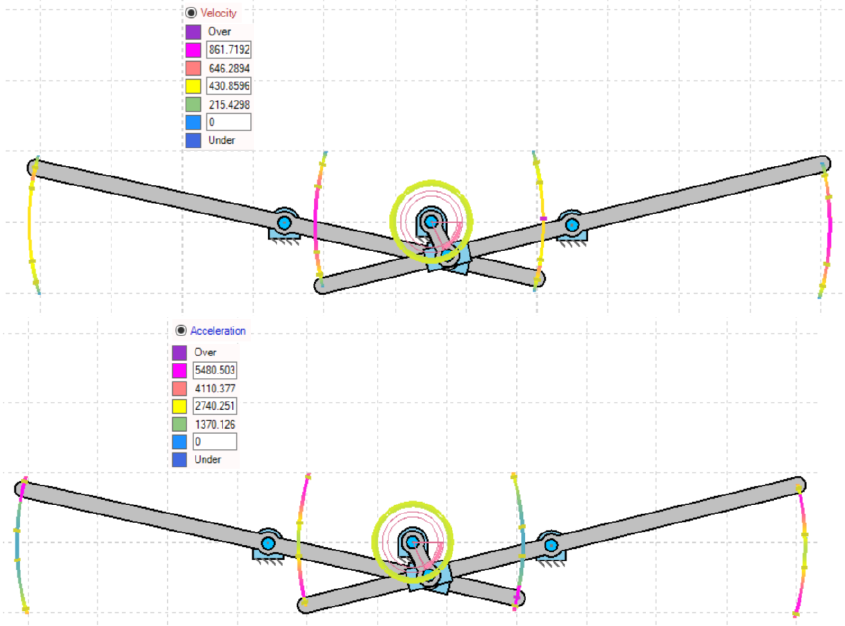
Figure 9. Color representation of variations in velocity and acceleration of design mechanism-II, at both lever paths of motion.